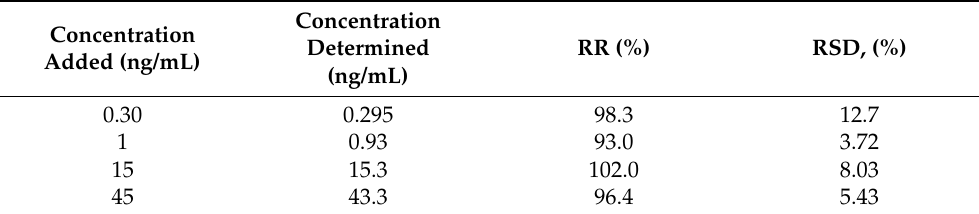
Table 3. Recovery analysis of the target analyte amended in wastewater by using the proposed assay